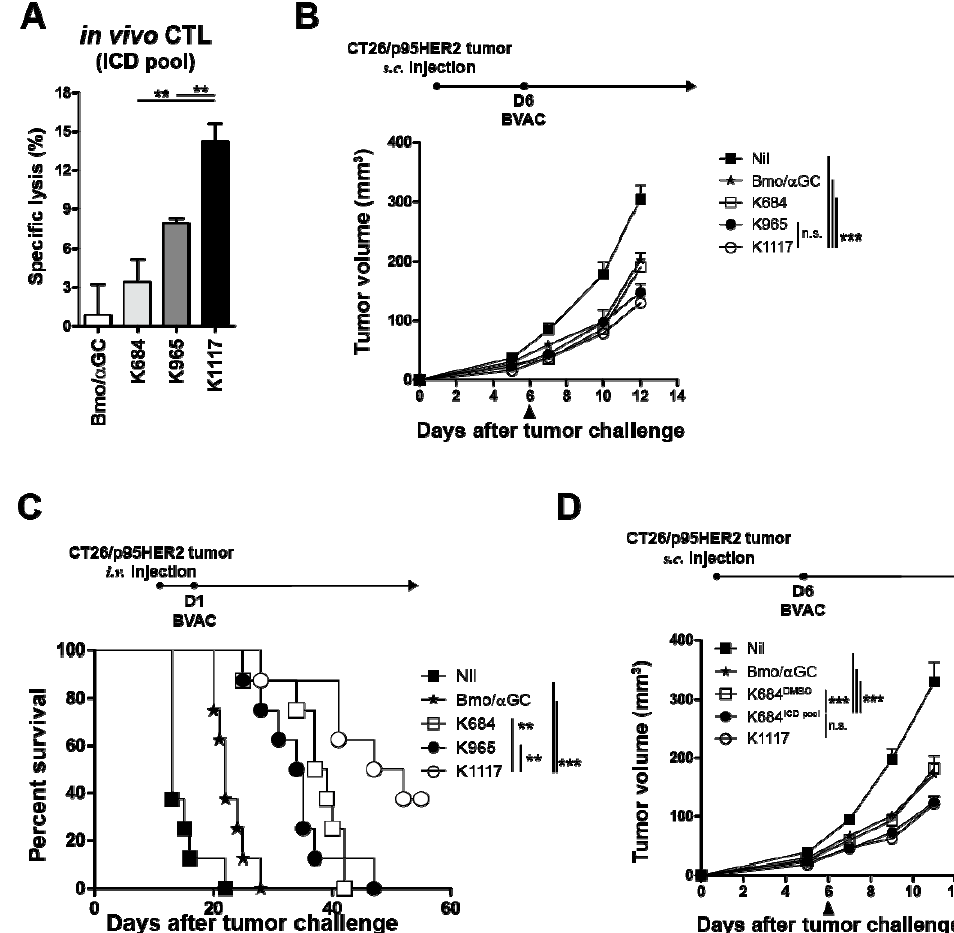
Figure 4. The function of epitopes located in the intracellular domain (ICD) of HER2. Naïve BALB / c mice were immunized with BVACs coding for each engineered antigen. On day 8, splenocytes from naïve BALB / c mice were pulsed with the HER2 ICD 15 mer peptide pool and labeled with CFSE high . Peptide loaded CFSE high labeled splenocytes were injected into immunized mice with the same number of peptide unloaded CFSE low labeled splenocytes as an internal control. One day after target cell injection, all mice were sacrificed, and specific cell lysis was analyzed with flow cytometry ( A ). A total of 2 × 10 5 CT26 / p95HER2 tumor cells were injected into the left flanks of naïve mice and tumor-bearing mice were immunized with BVACs as indicated ( B ). A total of 5 × 10 5 CT26 / p95HER2 tumor cells were injected into tail vein of naïve BALB / c mice. One day after tumor inoculation, tumor bearing mice were immunized with BVACs carrying the indicating engineered antigens and survival time was monitored ( C ). ( D ) The same as ( B ), 2 × 10 5 CT26 / p95HER2 were inoculated into the left flanks of naïve mice and administrated BVAC with indicated conditions. All statistical analyses were compared to K1117. All data are representative of at least three independent experiments except survival analysis (** p < 0.01, *** p < 0.001, n.s. p > 0.05).